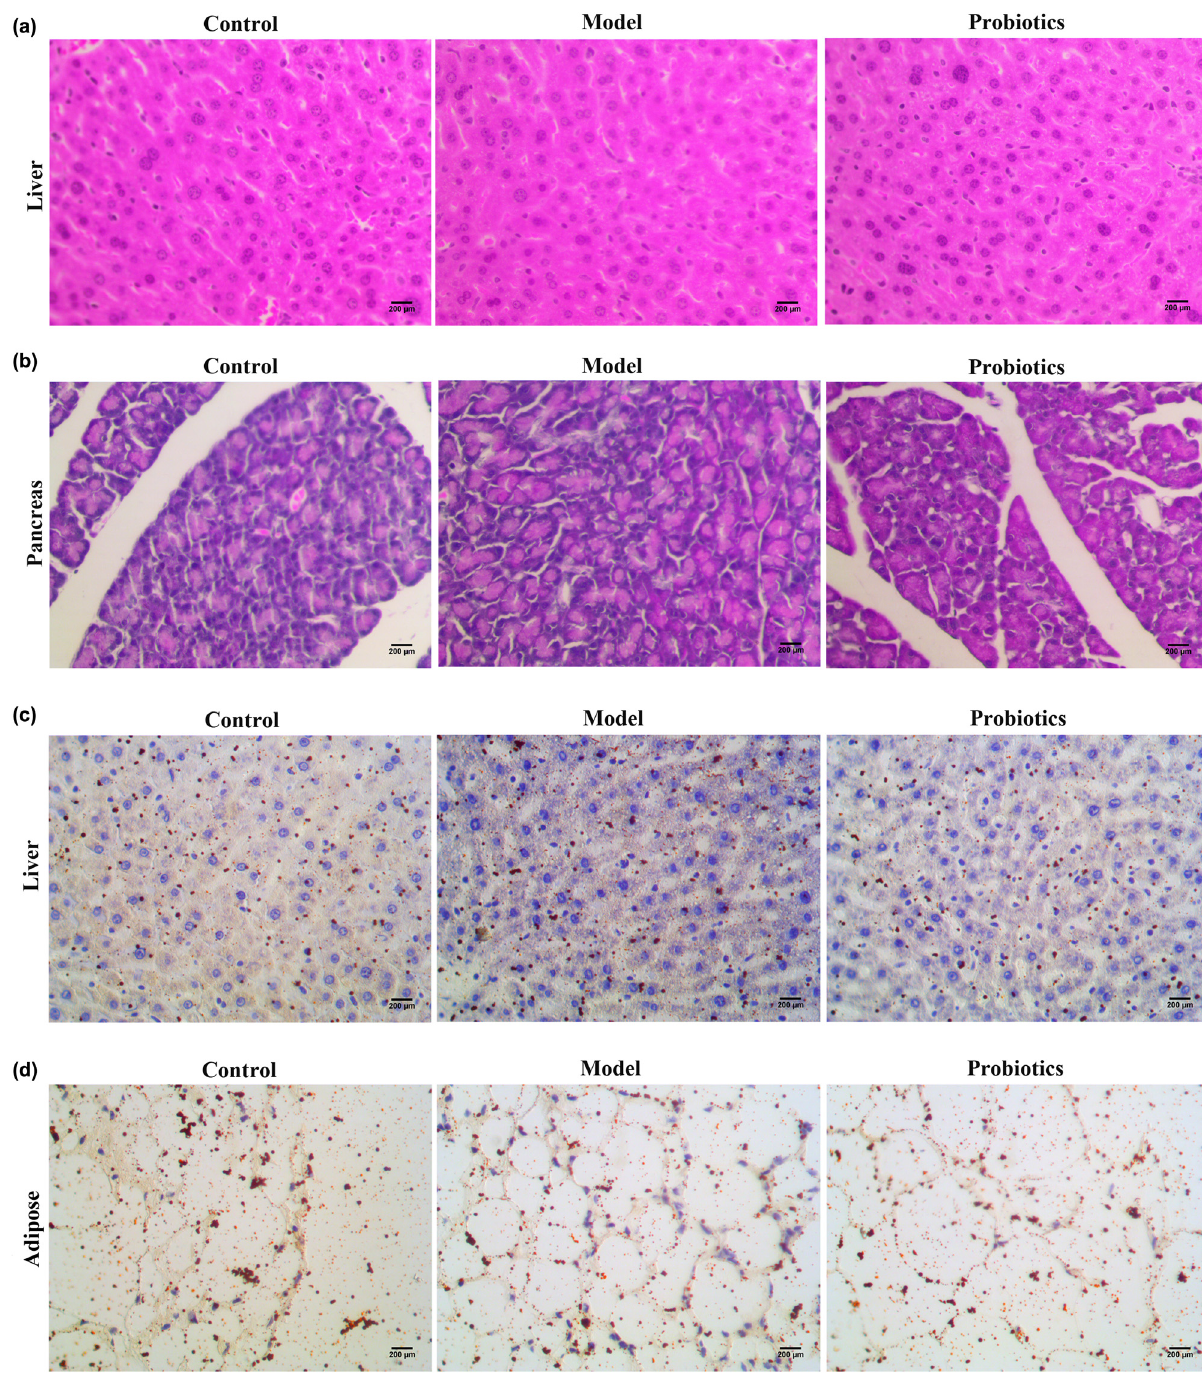
Figure 6: HE staining of liver and pancreas and relationship between Probio - M8 administration and in fl ammatory changes in epididymal adipose tissue and liver. ( a and b ) After the addition of Probio - M8, the histological changes in liver and pancreas in T2DM mice were improved. ( c ) Oil - red O staining of the liver tissues was presented. ( d ) Oil - red O staining of the epididymal adipose tissues was